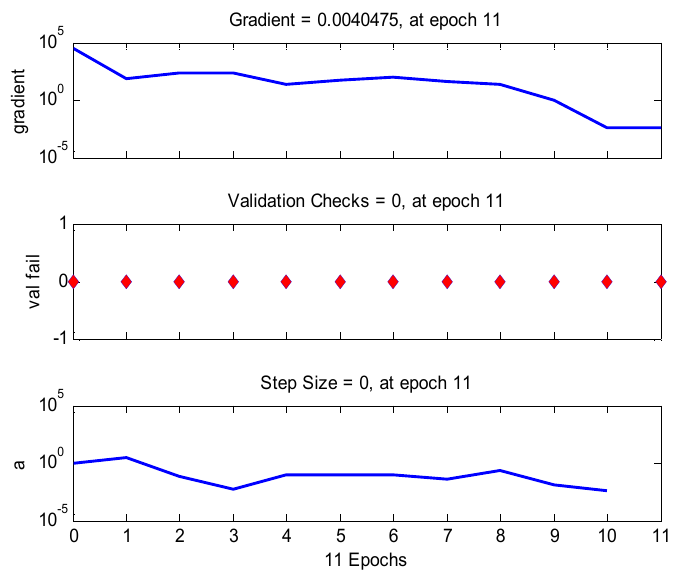
Figure 8. Error plot of the ANFIS controller.